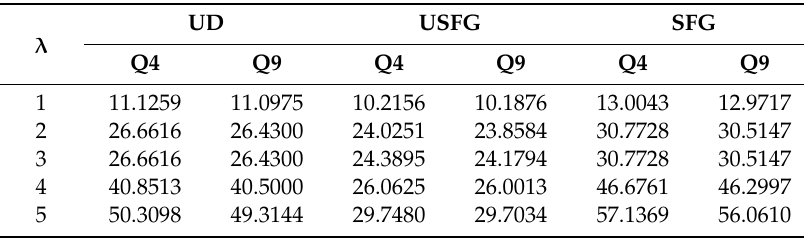
Table 7. First five natural frequencies for the FG-CNTRC square plate with di ff erent distributions without the agglomeration e ff